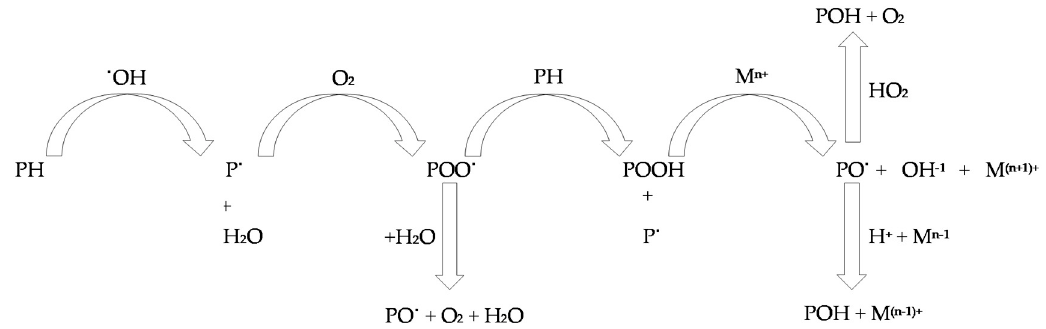
Figure 2. Mechanism of protein oxidation. PH: protein, • OH . : hydroxyl radical, P • : protein carbon-centered radical, H 2 O: water, O 2 : oxygen, POO • : analkylproxyl radical, PO • : alkoxyl radical, POOH: alkylperoxide, M n + : reduced forms of transition metals (Fe 2 + or Cu 1 + ), OH − 1 : hydroxide, POH: